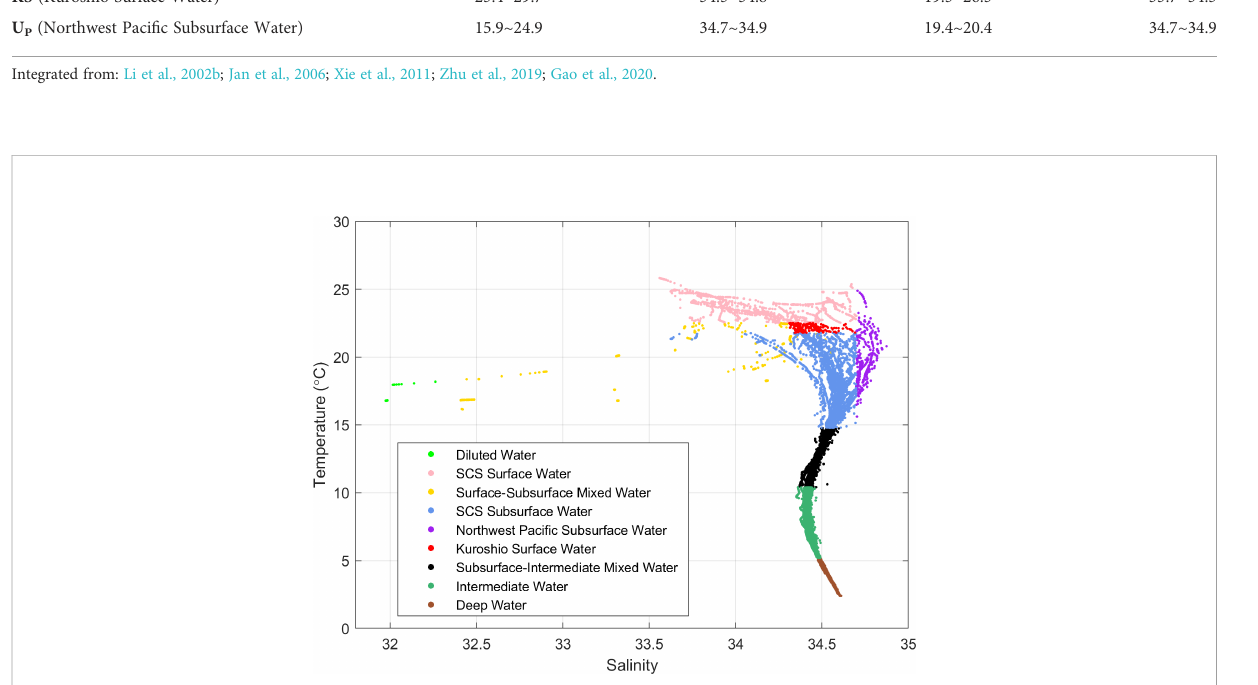
FIGURE 5 T-S diagram based on the observational data of the winter cruise in the Northern SCS in 2010. Data is from Zhu et al.